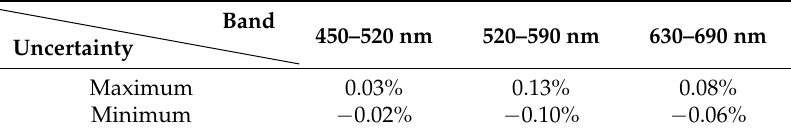
Table 5. Maximum and minimum value of σ i induced by ozone measurement errors in the 22